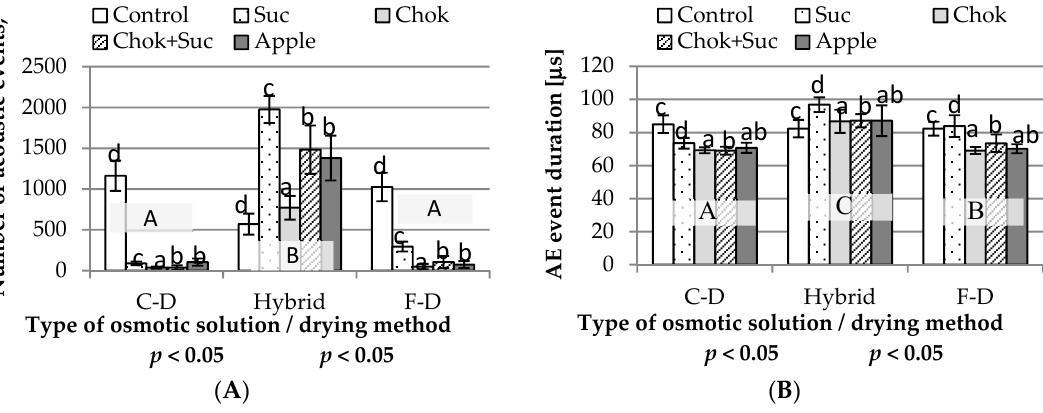
Figure 5. Influence of the type of osmotic solution and drying method on: ( A ) number of acoustic events and ( B ) AE event duration in breaking test of quince chips. Designations: a–d and A–C—homogeneous groups; Suc, Chok, Chok + Suc, apple—coding the type of osmotic solution and C-D, Hybrid, F-D—coding the type of drying method as given in the experimental procedure.